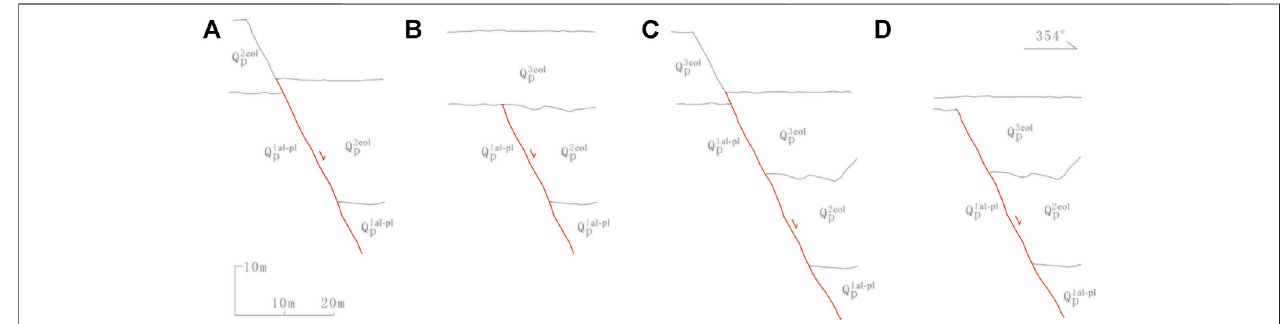
FIGURE 6| (A) Schematic diagram ofpaleoseismic eventI. (B) Schematic diagram between paleoseismic eventI and paleoseismic eventII. (C) Schematic diagram of paleoseismic eventII. (D) Schematic diagram of present geological pro fi le.